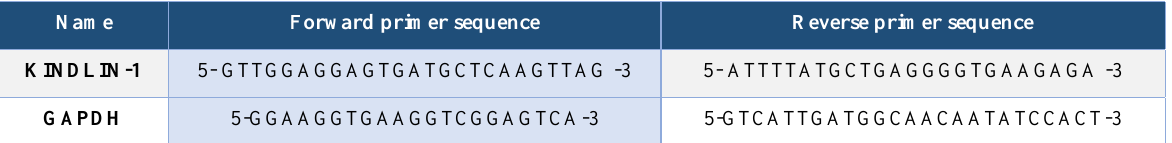
Table 1. Primer sequences used for quantitative real-time RT-PCR.